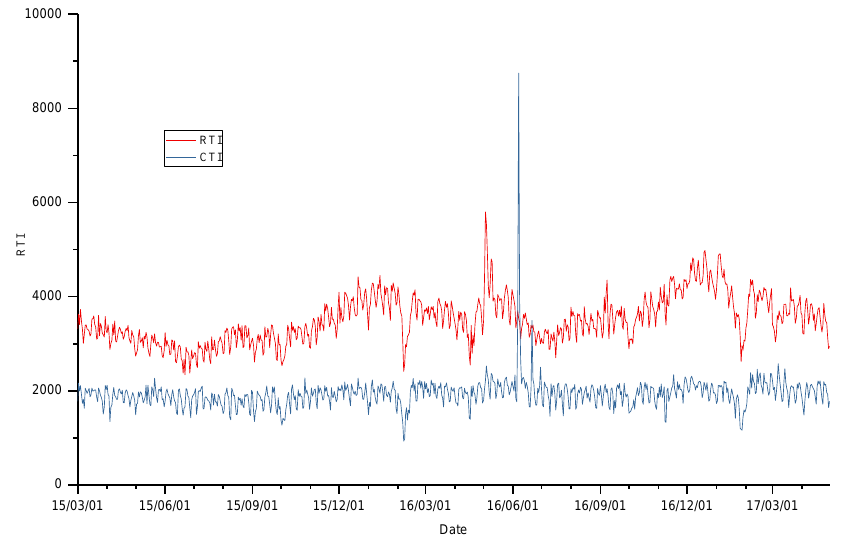
Figure 4. The time series of daily respiratory total index (RTI) and cardio- and cerebrovascular total index (CTI).